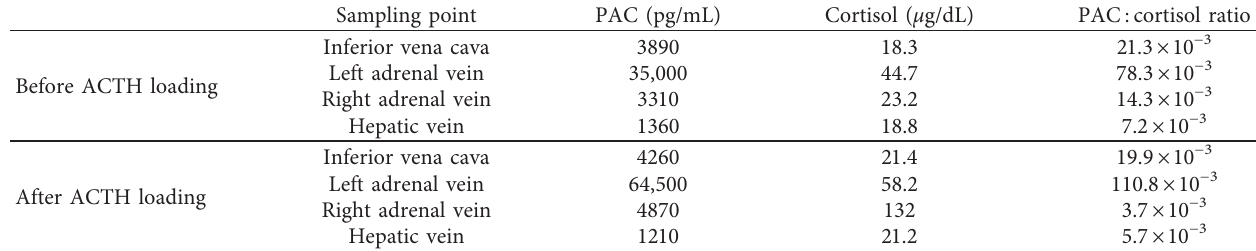
Table 3: Adrenal and hepatic venous sampling.